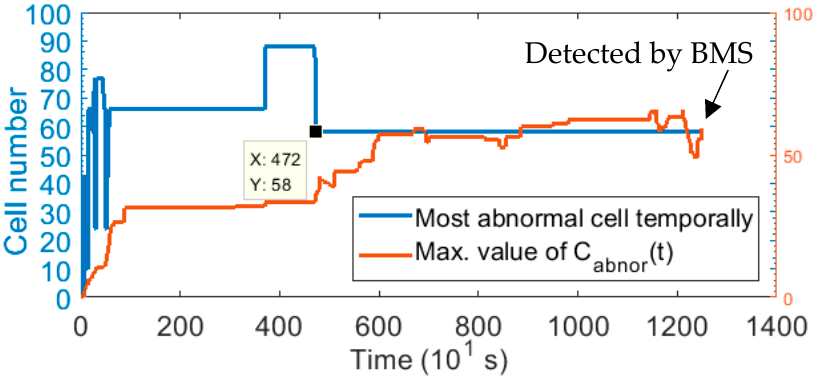
Figure 9. The most abnormal battery cell temporally, determined by the cell with the largest C abnor ( t ) with d = 0.1 in case 2.